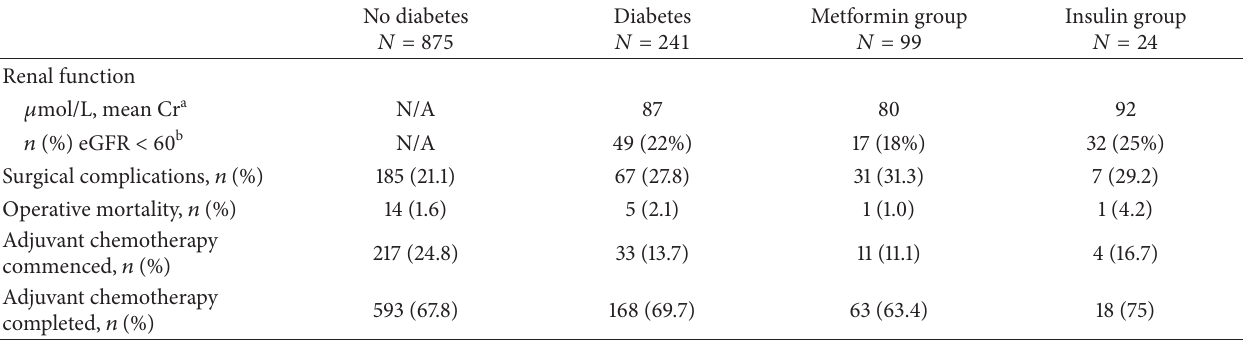
Table 3: Operative morbidity and mortality, adjuvant treatment commenced, and completed details of nondiabetes versus diabetes patients, including metformin and insulin treated subsets.